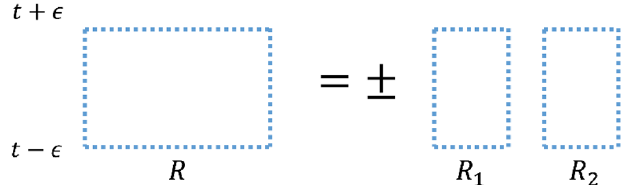
Figure 10 . The splitting of the symmetry line U g ( M ) (shown in dotted blue lines) of a Z 2 global symmetry in 2d, where M is the boundary of the rectangle R × [ t − (cid:15), t + (cid:15) ] . This splitting obeys (6.2). For a non-anomalous (anomalous) Z 2 global symmetry, we have a + ( − ) sign on the right-hand side [23, 62, 63]. The Z 2 symmetry of the Ising model is non-anomalous and therefore the sign above is +